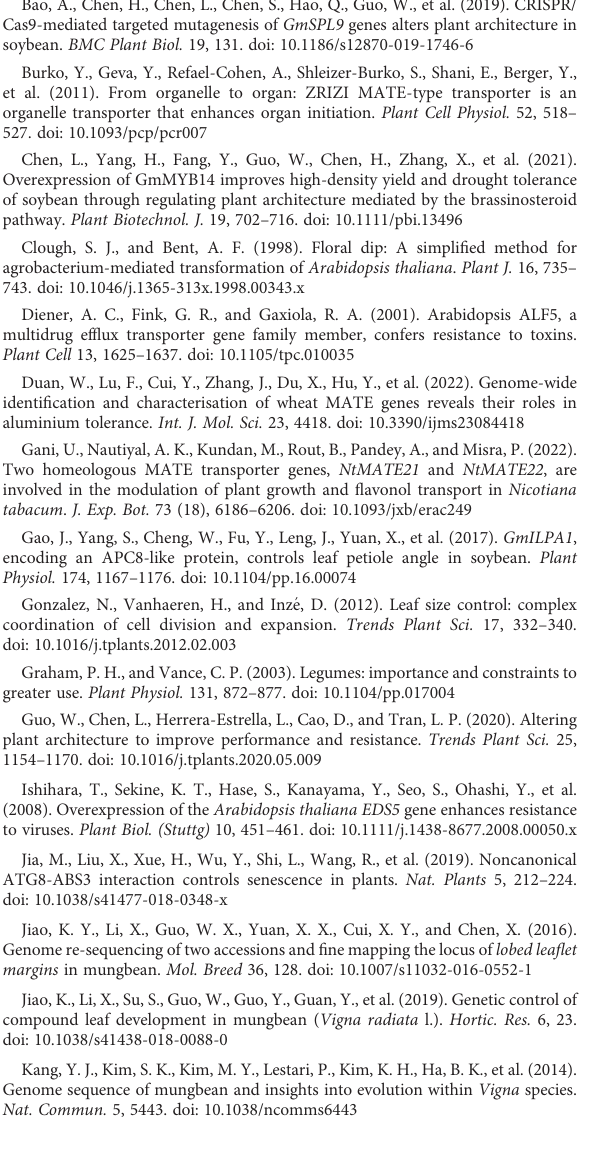
SUPPLEMENTARY TABLE 2 MATE family proteins used for phylogenetic analysis in this study.